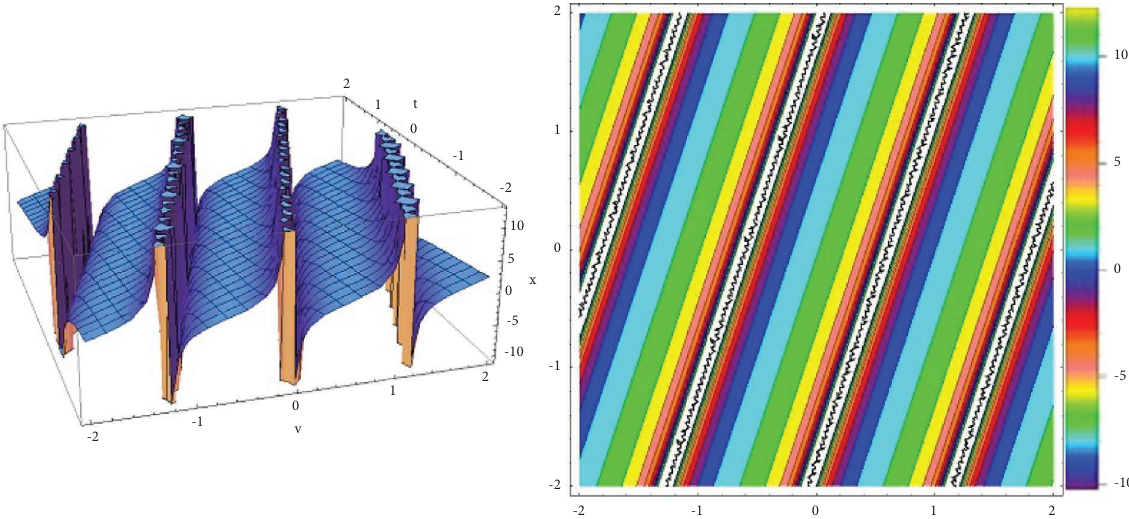
Figure 9: Multiple singular periodic soliton depicted from (34) for ω �